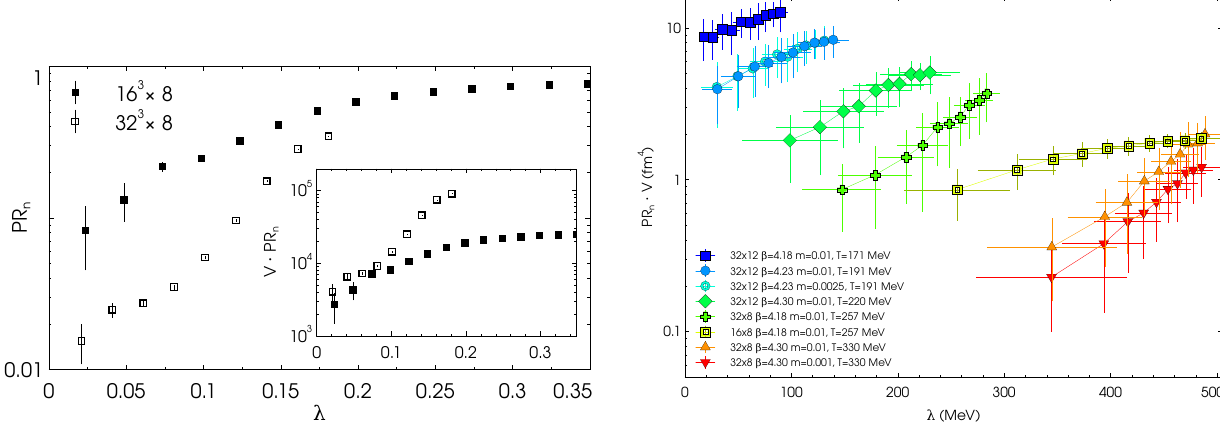
Figure 11. Scaling of the PR (and of V PR in the inset) for β = 4.18, N t = 8 ( T = 257MeV 1.5 T c ) and bare mass m = 0.01 · (cid:39) ( left ), and dependence on T and m of the PR of the 10 lowest modes ( right ) in two-flavor QCD with Möbius domain-wall fermions. From Ref. [39]. (Figures adapted from G. Cossu and S. Hashimoto, J. High Energy Phys. 06, 56 (2016), and used under a CC-BY 4.0 license